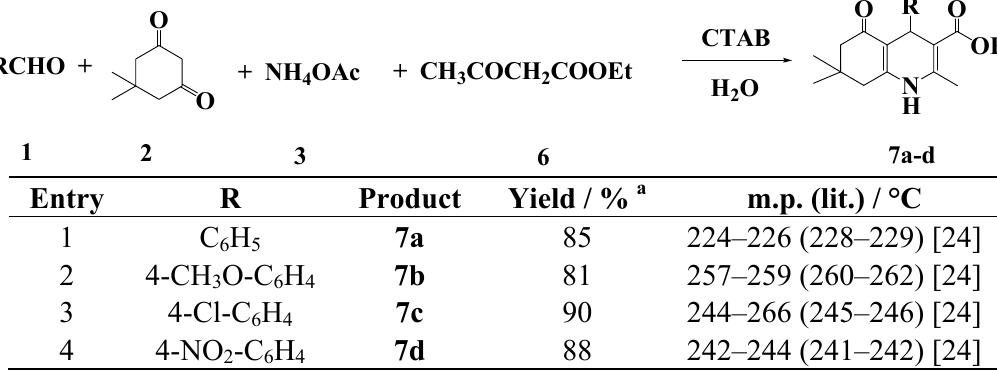
Table 3. Yields and melting points for the one-pot synthesis of polyhydroquinoline